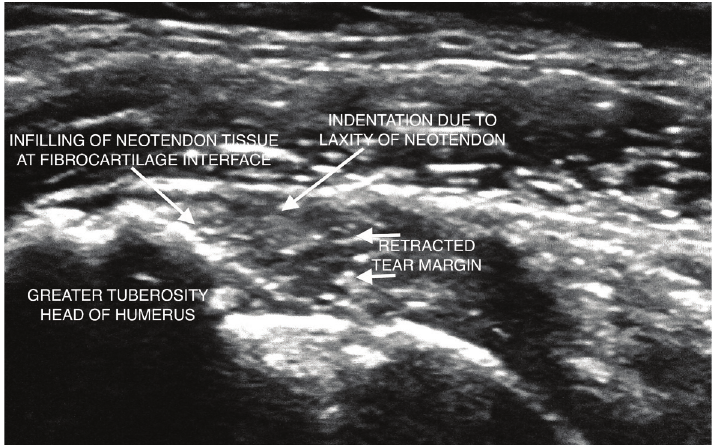
Figure 2. At follow up there is neotendon infilling in place of the tear defect. The lateral tear margin has retracted with mild interval attrition of the supraspinatus tendon. At the time of this follow up study the patient had a dramatic return to a completely pain free state and had full range of movement with no